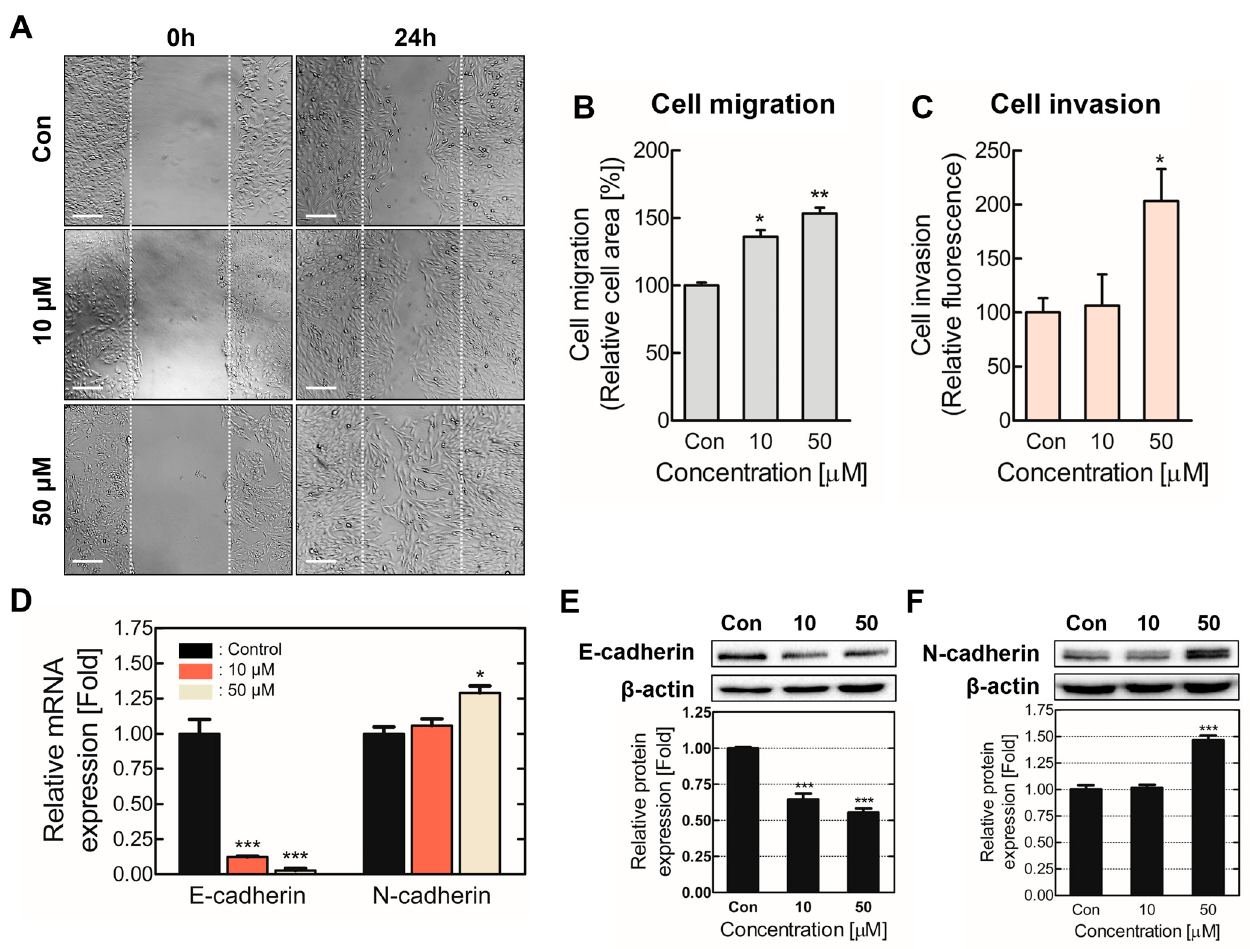
Figure 3. Chronic TDI exposure increased cell migration and invasion. ( A ) Cell migration in the chronically TDI-exposed model was observed through microscopy. ( B ) Migration quantification is represented in the bar graph. ( C ) Chronically TDI-exposed BEAS-2B’s basement membrane permeability was analyzed through a cell invasion assay. E-cadherin and N-cadherin ( D ) intracellular genes and ( E , F ) protein levels were detected. Cell adhesion molecules involved in cell migration and invasion were evaluated in the chronic TDI exposure model. Every experiment was performed over three times. * p < 0.05; ** p < 0.01; *** p < 0.001 compared to the control group; Con: control; Scale bars: 200 μ m.